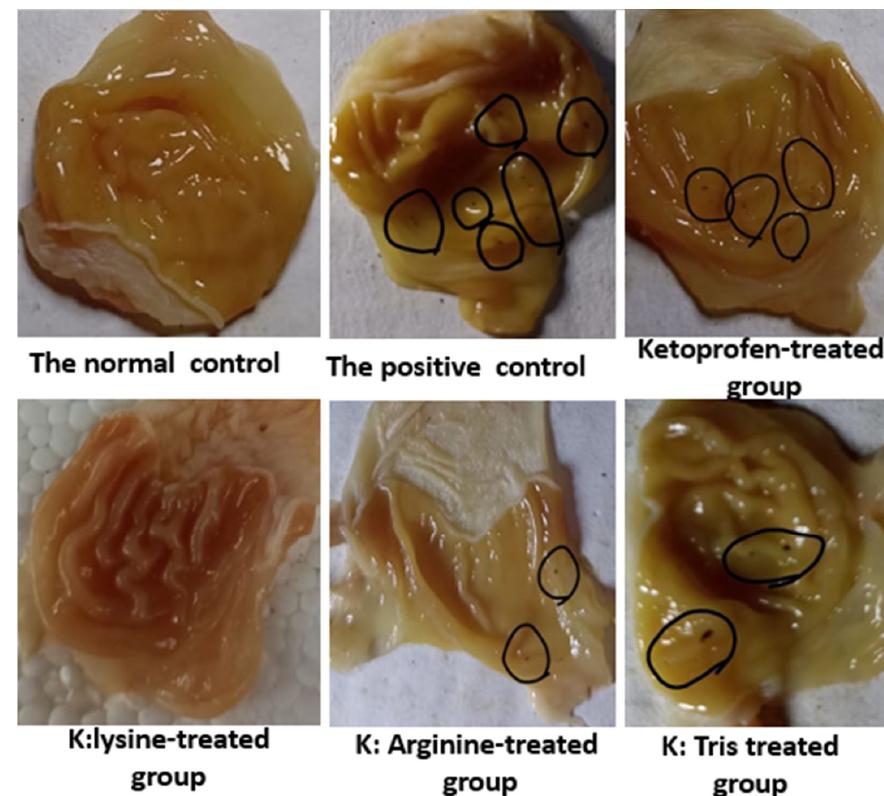
Figure 8. Pinned stomachs on corkboards highlighting the position and number of ulcers (encircled in black lines) for the negative and positive control (indomethacin), ketoprofen (K), K:lysine, K:arginine:K:tris coprecipitated mixtures.